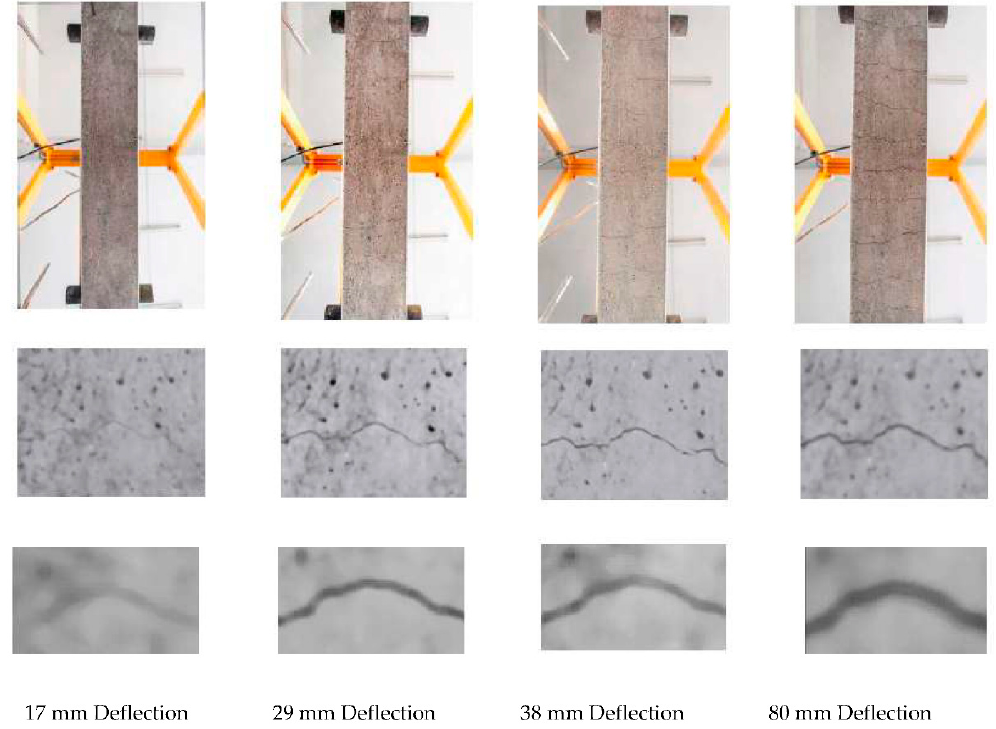
Figure 7. Significant shots used for analysis. Up to 140 shots per sequence were carried out. Columns show different deflection status, while rows show different zoom images.